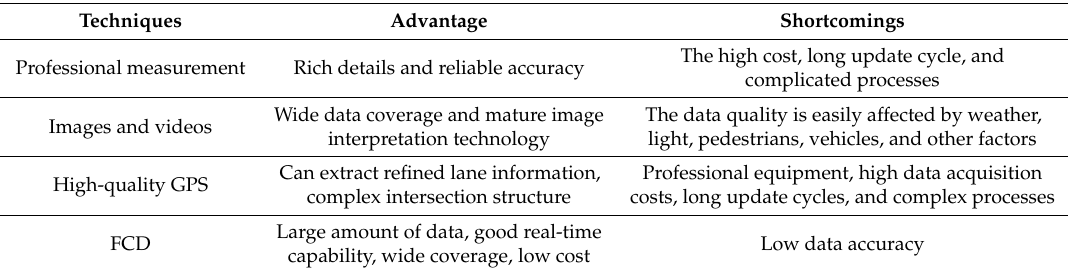
Table 1. Contrast analysis of lane number detection